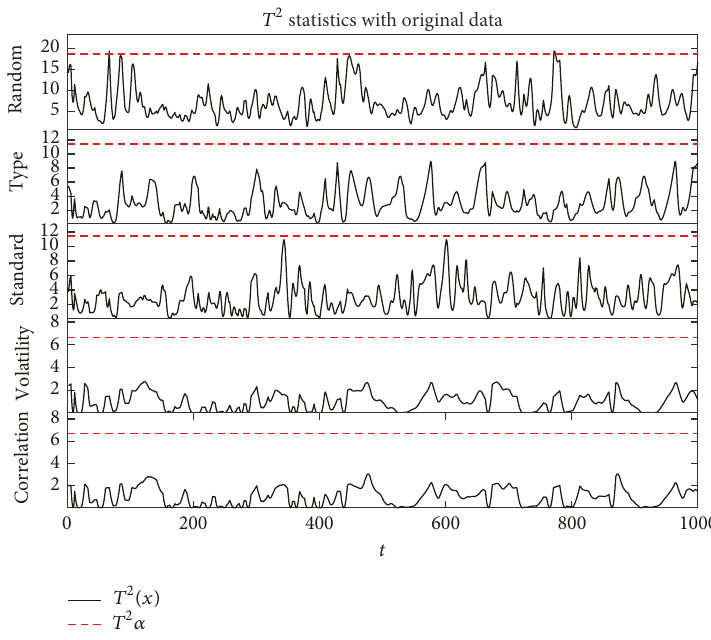
Figure 8: 𝑇 2 statistics with preprocessed data in 5 PCA models.